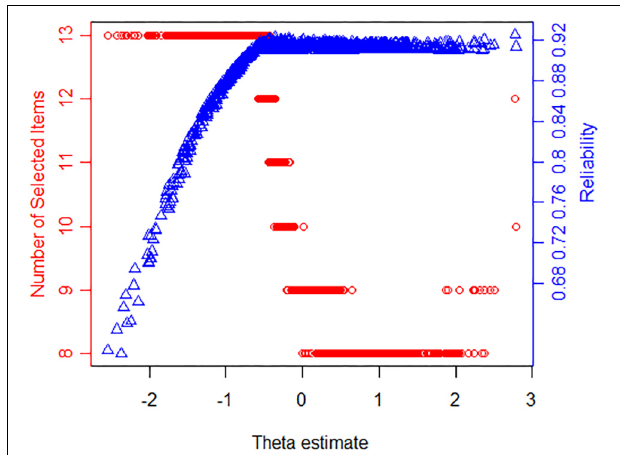
Marginal reliability